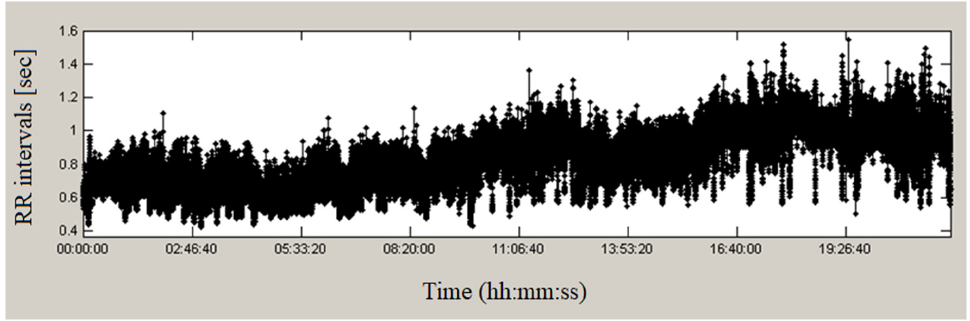
Figure 2. RR intervals of a healthy individual.